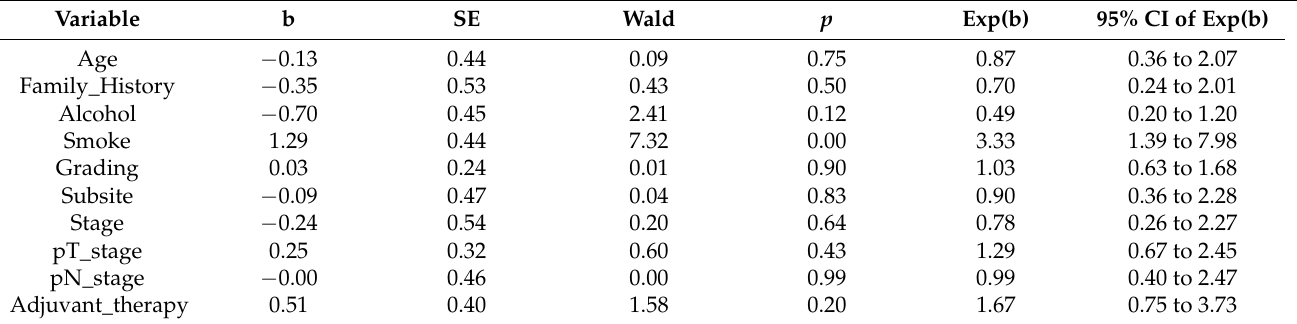
Table 2. Cox proportional-hazards regression analysis of the clinical-anamnestic data as risk factors on 5-years Overall Survival.